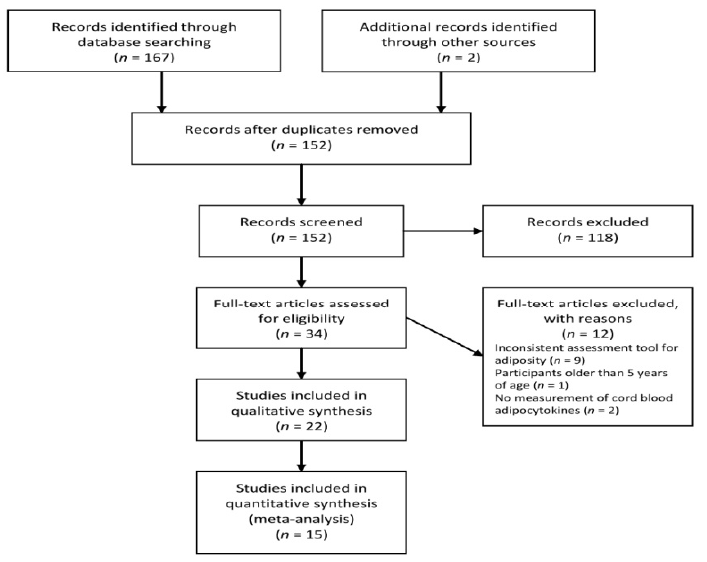
Figure 1. Flow diagram of the